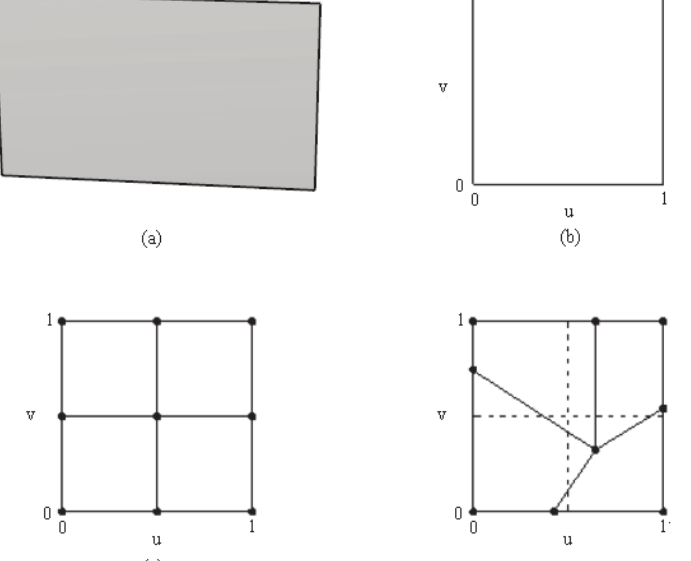
Figure 1: (a) NURBS model of a masonry wall. (b) Counter-image I w of the NURBS surface in the parameters space u-v . (c) Initial subdivision of the parameters space into four rectangular elements. (d) Modified subdivision of the parameters space into four generic quadrilateral